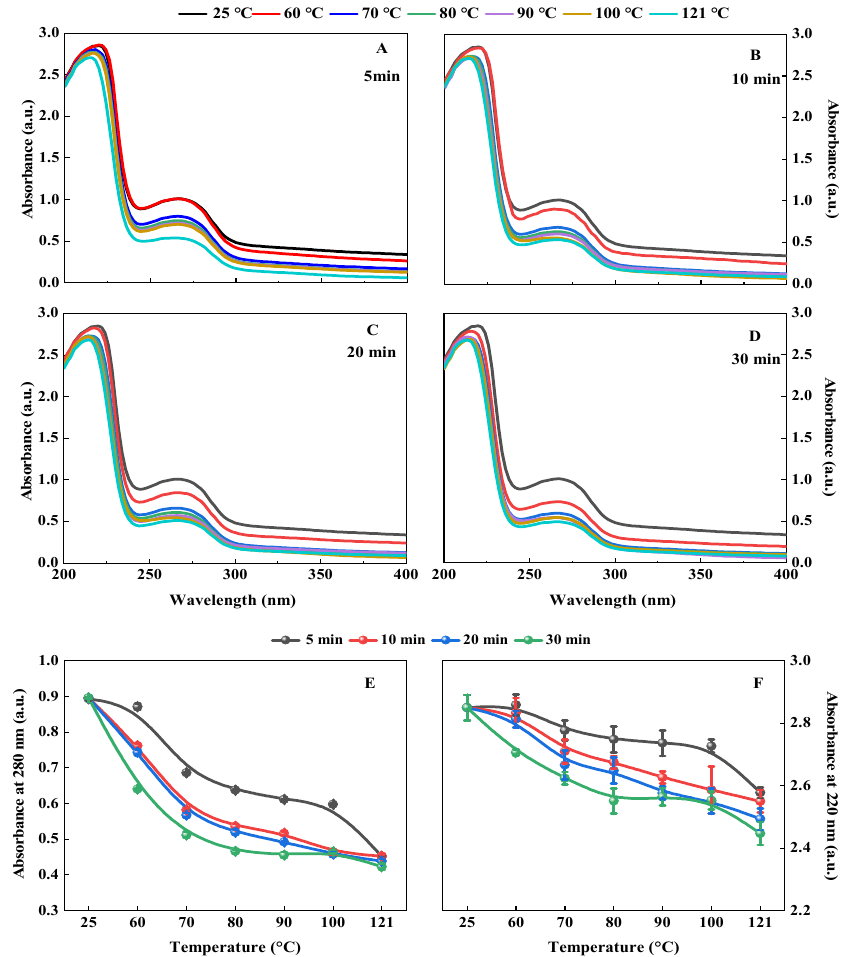
Figure 4. Effects of hydrothermal treatment of 5 min ( A ), 10 min ( B ), 20 min ( C ), and 30 min ( D ) on the UV absorption spectrum of QPI and the absorption value at wavelengths of 280 nm ( E ) and 220 nm ( F ), respectively.